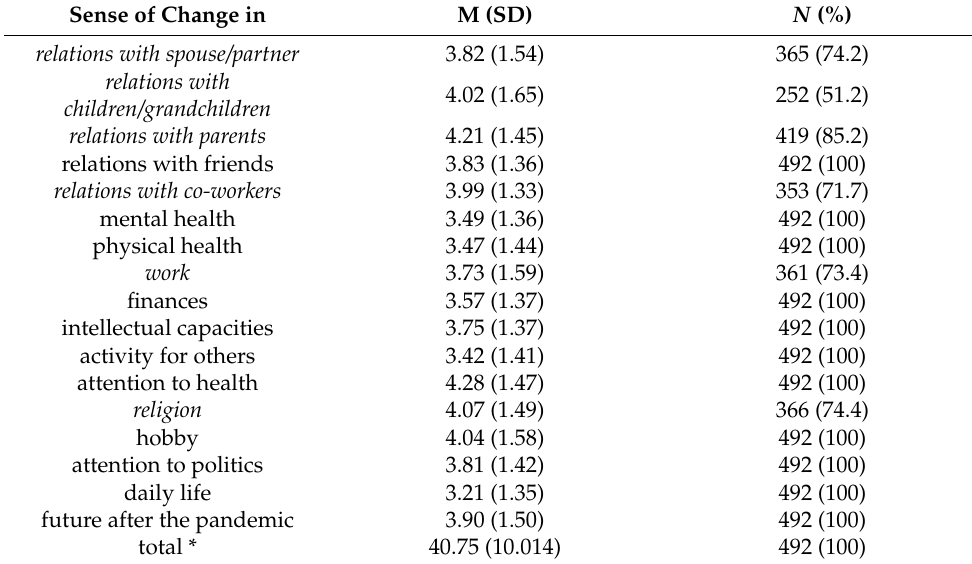
Table 3. Scores in the Sense of Life Changes Questionnaire (COVID-19 SLCHQ; N = 492; total sample). Sense of Change